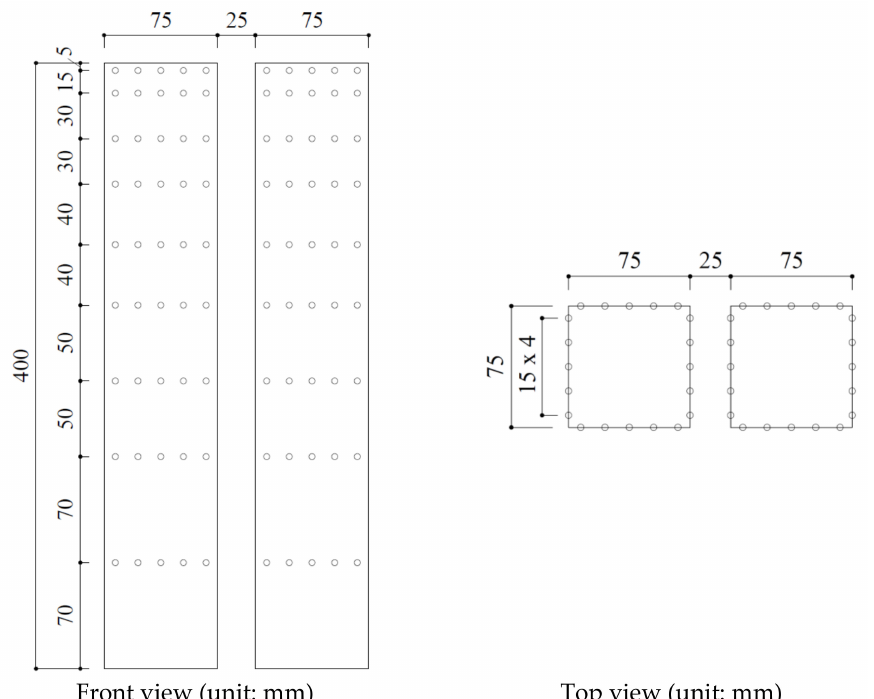
Figure 5. Building model size and location of pressure taps.